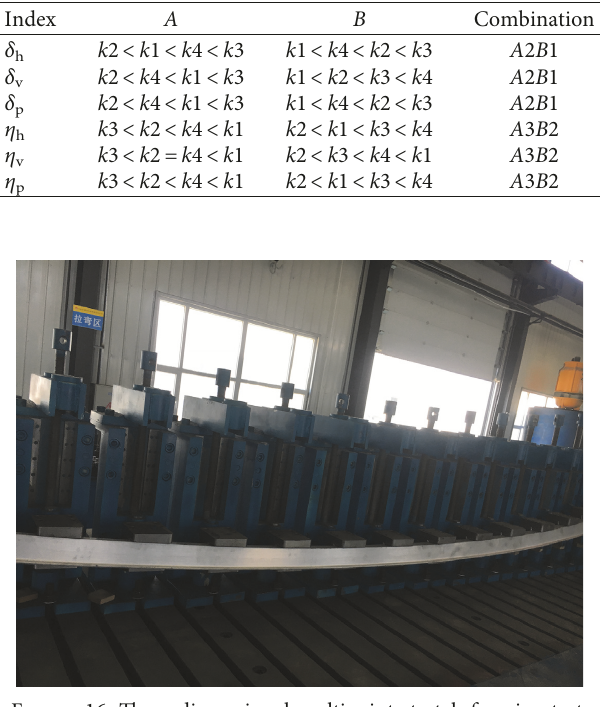
Figure 16: Three-dimensional multipoint stretch forming